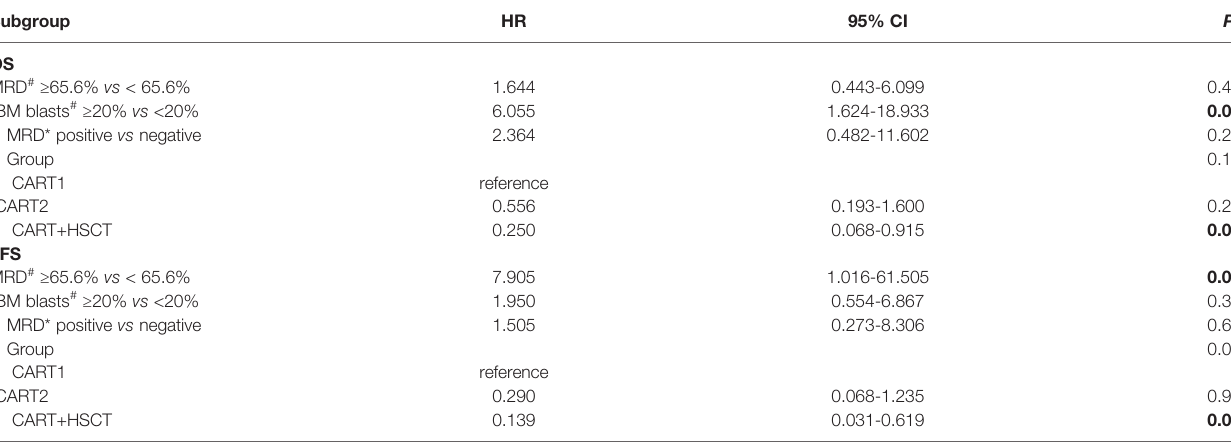
OS, overall survival; LFS, leukemia-free survival; CART, Chimeric Antigen Receptor T-Cell (CAR-T) therapy; # before CAR-T therapy; *after CAR-T therapy; MRD, minimal residual disease; BM,bone marrow; CART+HSCTgroup,patients whoreceived allogeneichematopoietic stem cell transplantation afterCAR-T; CART2group,patients whoreceived a secondhCART19s infusion after CAR-T; CART1 group, patients who did not receive HSCT or a second hCART19s infusion. Bold values, statistical signi fi